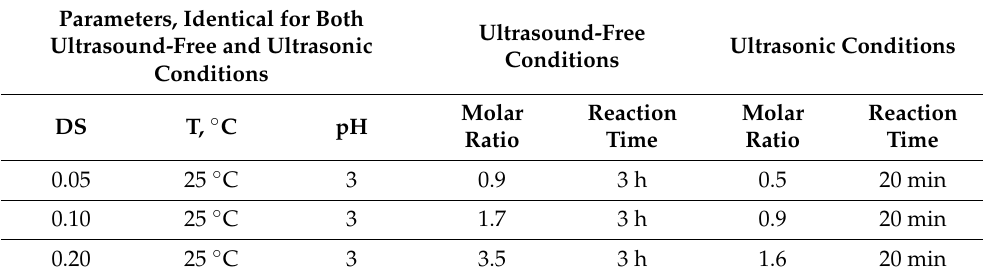
Ultrasound-Free Ultrasonic Conditions Conditions Molar Reaction Molar Reaction Ratio Time Ratio Time